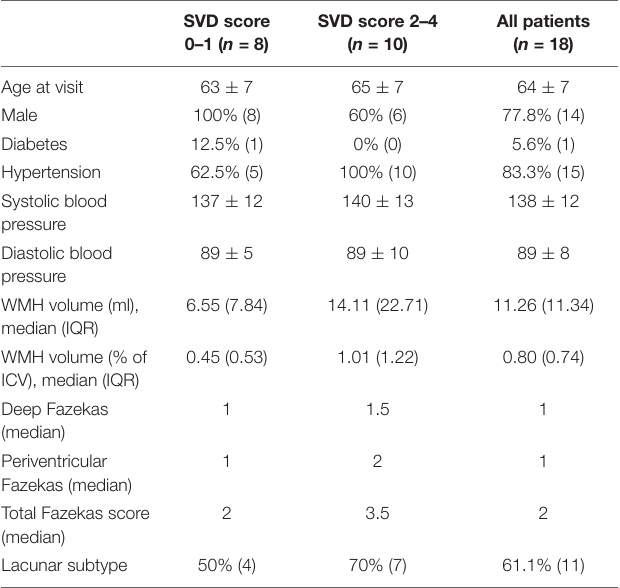
TABLE 2 | Demographic data of patients by SVD score (numerical variables: mean ± standard deviation (if normally distributed) or median (interquartile range); summary statistics: % of group (number); categorical variables presented as